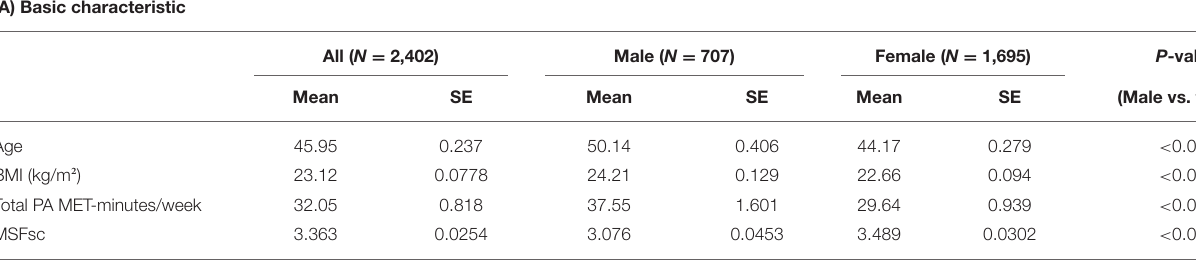
TABLE 1 | Basic characteristics of participants and correlation analysis of basic characteristics and blood